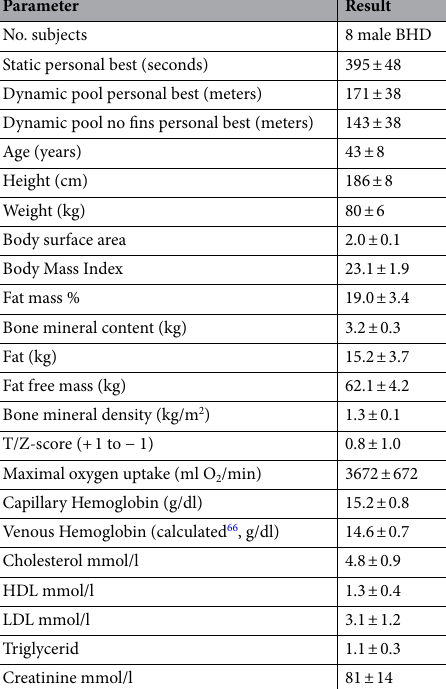
Table 1. Subject characteristics. Basic morphometric data. Values are mean ± Standard Error of Means. BHD breath hold divers, HDL High density lipoprotein, LDL low density